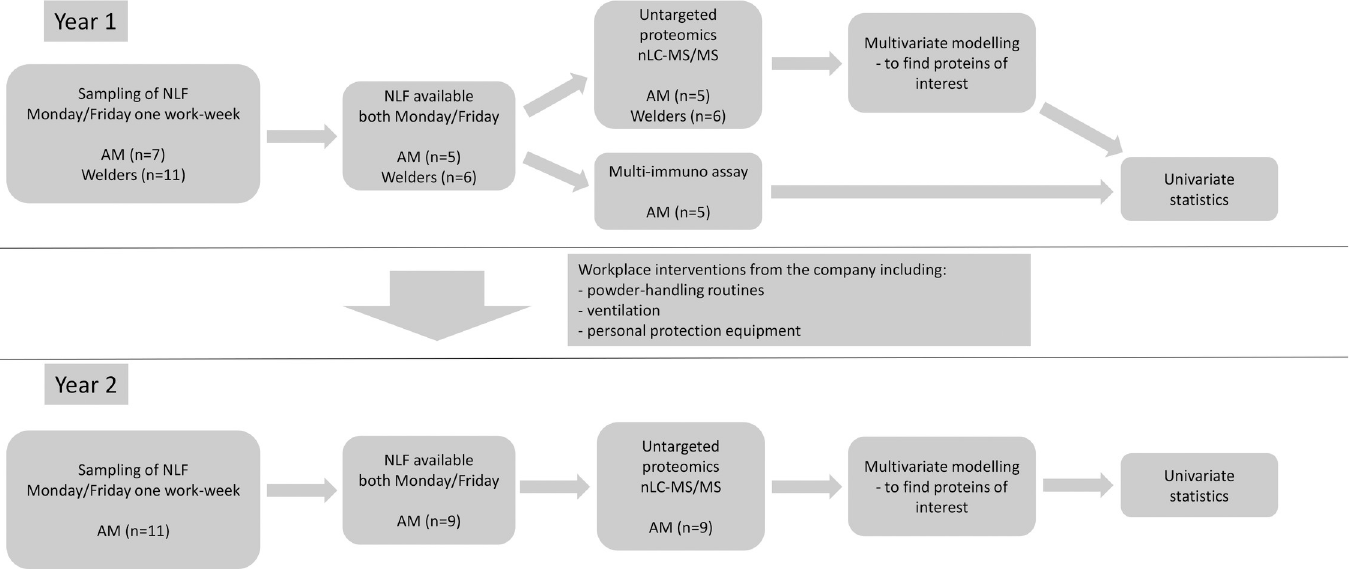
Fig 1. Flow-chart of study